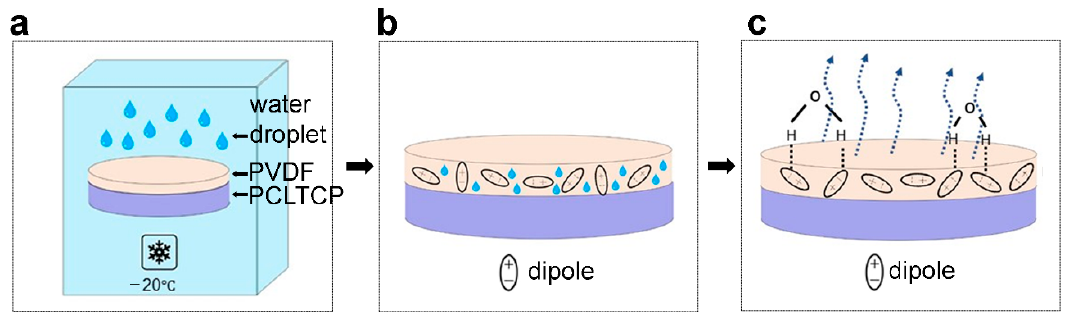
Figure 6. Schematic of the self-poling effect of PVDF-coated PCL-TCP scaffold fabricated using modified breath-figure method. ( a ) Scaffolds are conditioned in a closed chamber at − 20 °C. ( b ) Water droplets sink into the polymer matrix and interacted with PVDF molecular dipoles. ( c ) Water molecules evaporate and leave the polymer surface, lifting negative dipoles by hydrogen bonding.